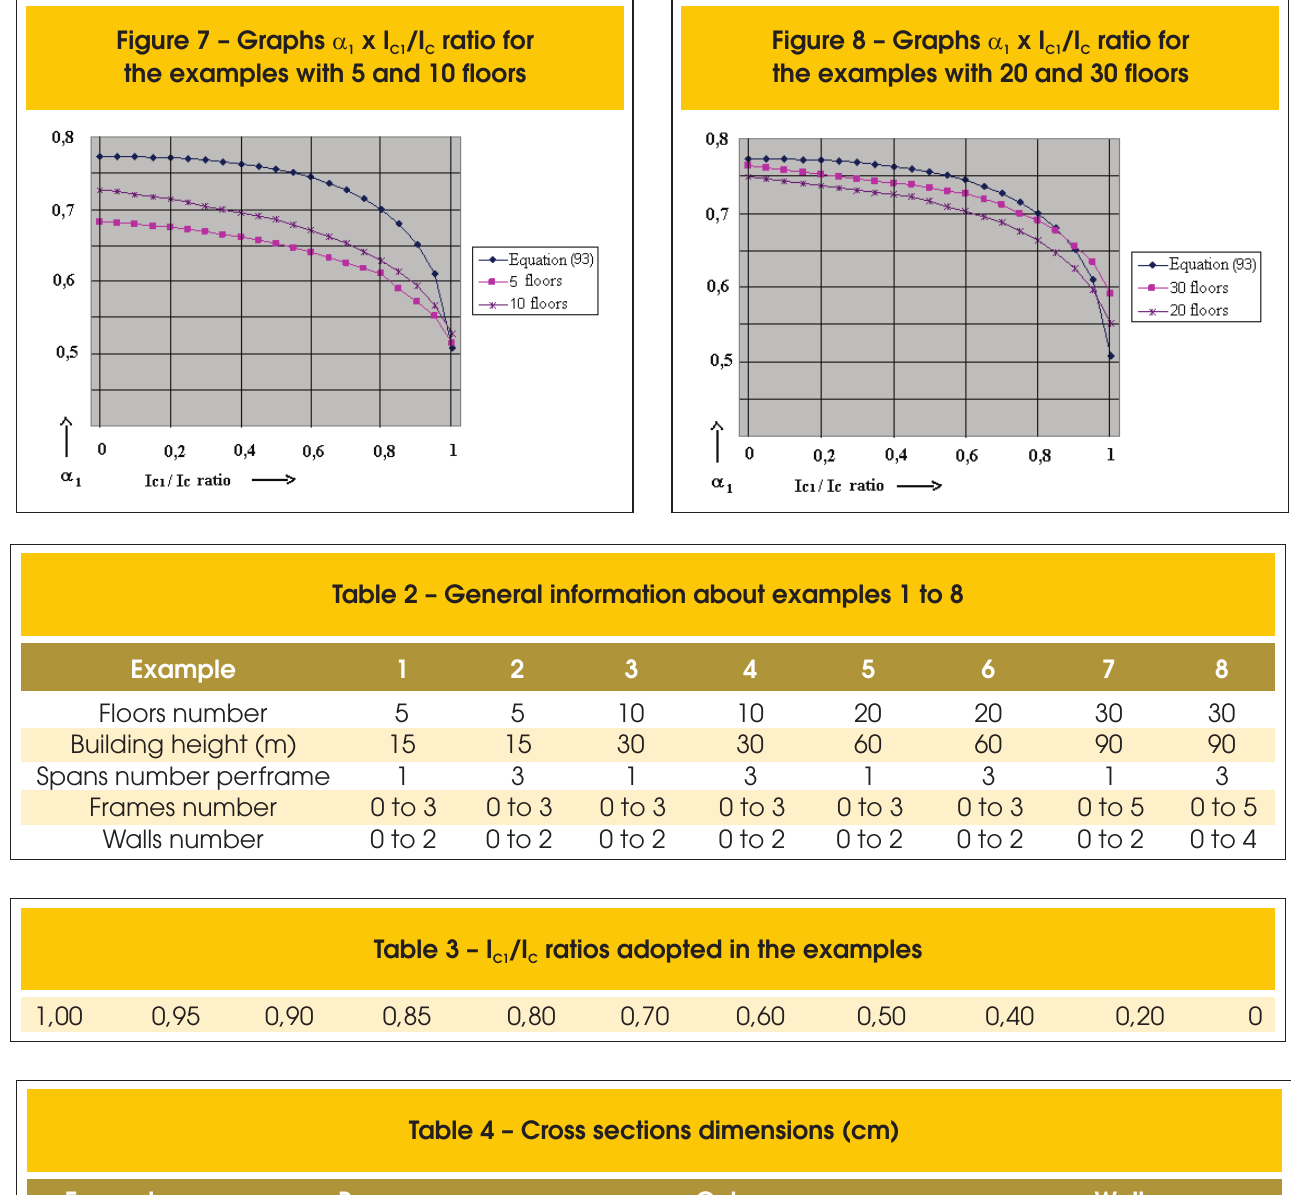
Figure 8 – Graphs a x I /I ratio for 1 C1 C the examples with 20 and 30